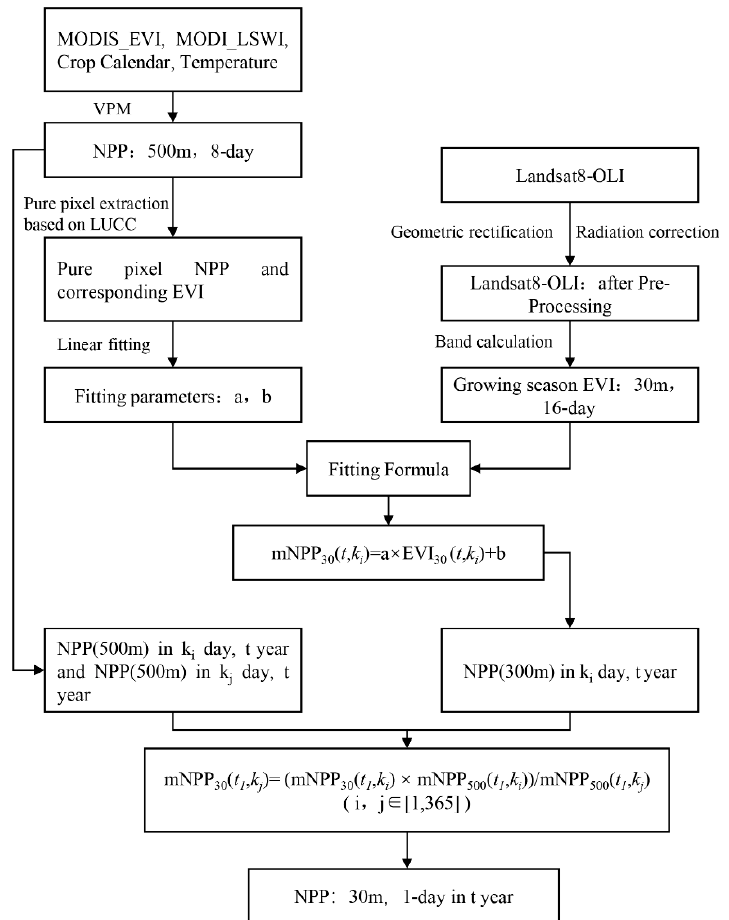
Figure 4. The process diagram of estimate 30 m NPP using time series fitting method.